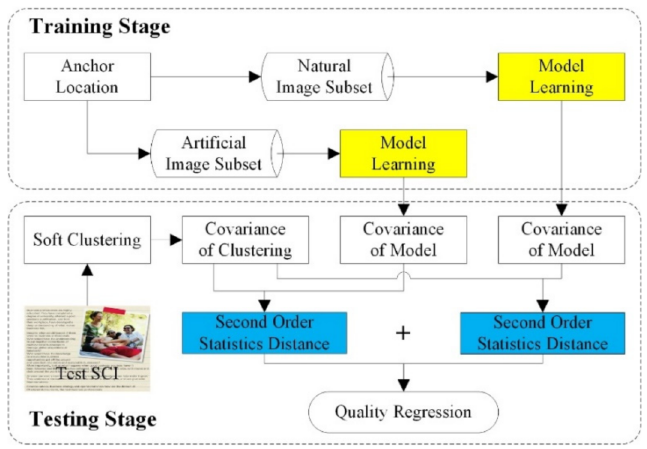
Figure 1. Flowchart of the proposed DAML method for